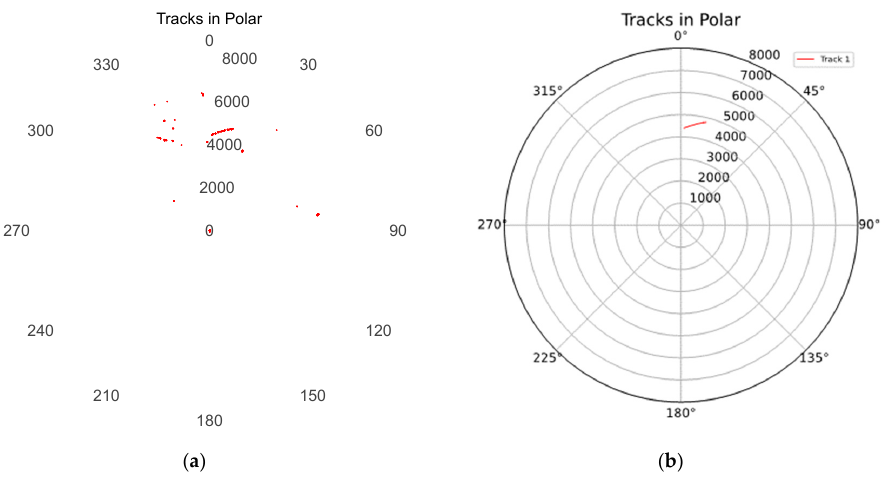
Figure 6. Polar coordinate tracking under single-target tracking. ( a ) The point target’s tracks. ( b ) The extended targets’ tracks.